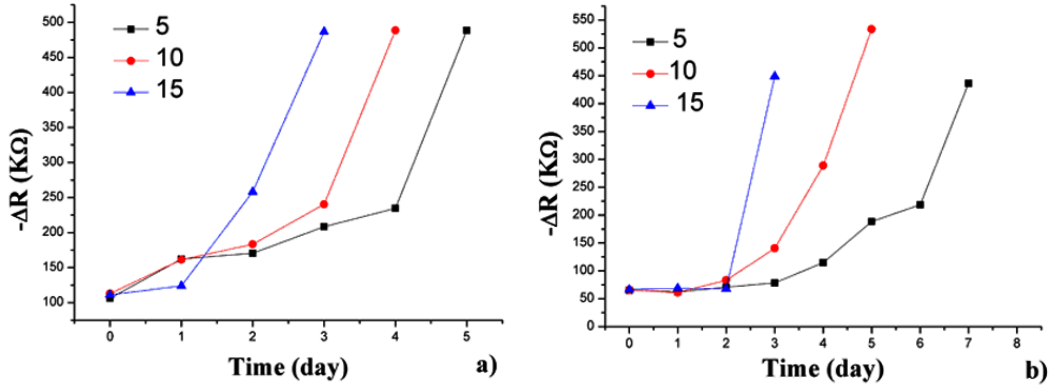
Figure 5. Time response of S5 at different temperatures for hairtail fish ( a ) and pork ( b